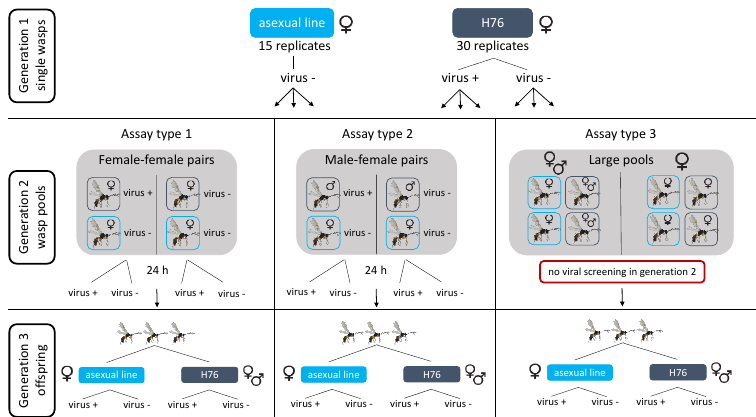
Figure 1. Experimental setup of wasp pools for the transmission assay, to test possible modes of transmission (horizontal and vertical) with the wasp lines reared for three generations. Generation 1 consisted of single female wasps reared on aphid hosts. The uninfected asexual line was combined with infected and uninfected individuals of the H76 line to create either female–female, male–female pairs, or large pools for generation 2. Wasps in pairs were put on aphid hosts for 24 h before being removed and screened for the virus. Wasps in large pools were not removed nor screened for the virus at generation 2. Generation 3 consisted of sampling the offspring of the pooled lines, sorting them based on line and subsequently testing for the presence of the virus.